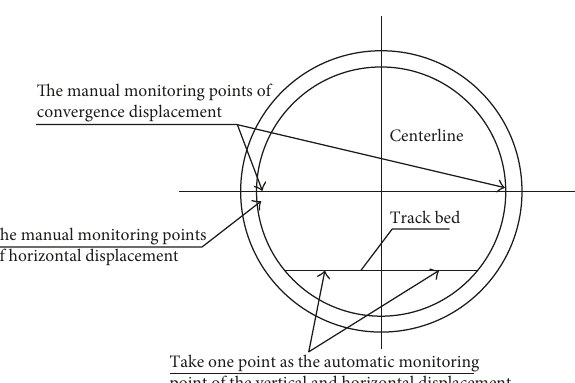
Figure 7: The grouting volume.